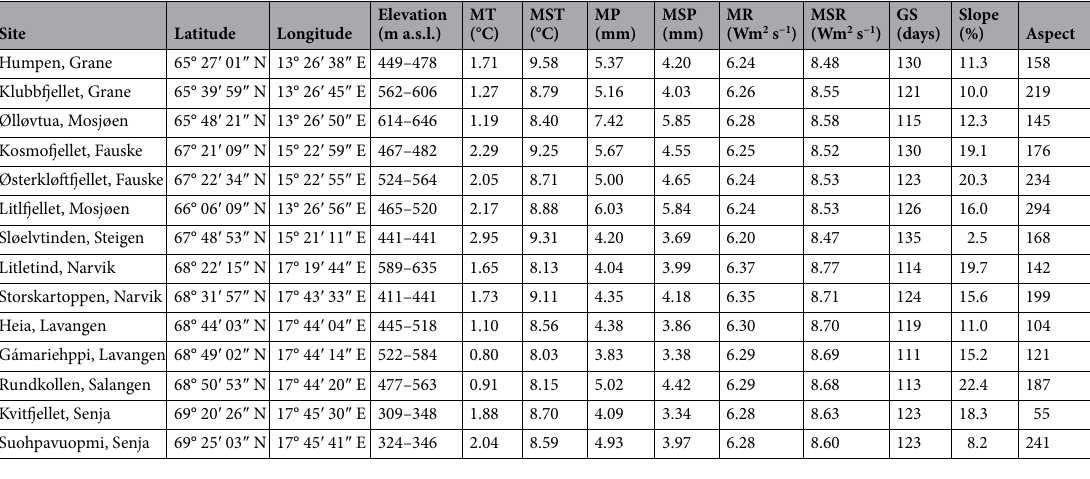
Table 1. Location and characteristics of the 14 study sites. MT mean temperature, MST mean summer temperature, MP mean precipitation, MSP mean summer precipitation, MR mean solar radiation, MSR